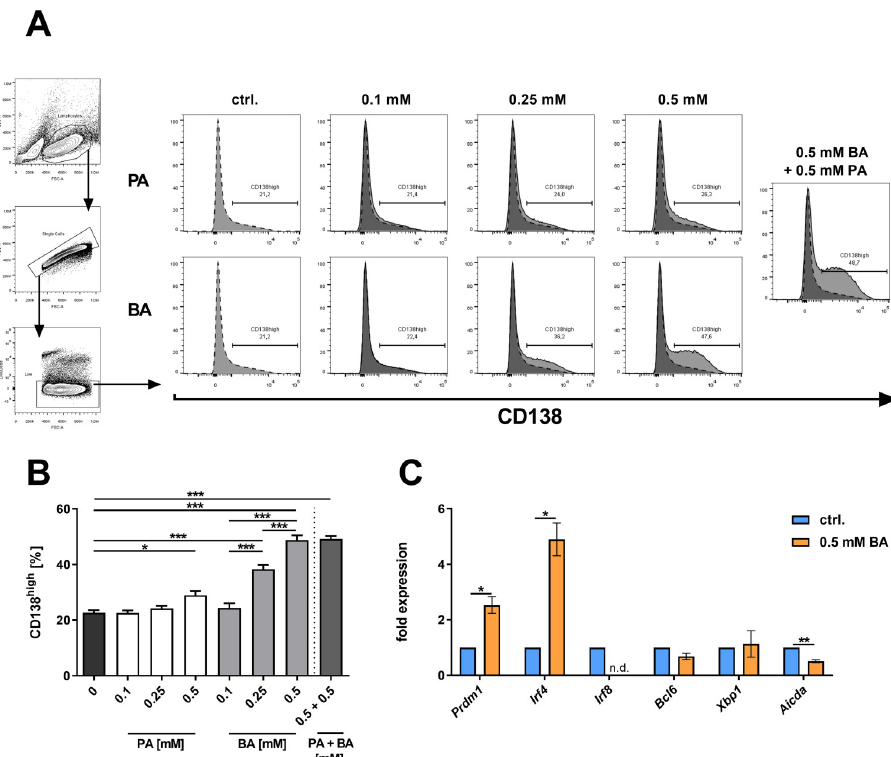
Fig 1. Butyrate promotes the differentiation of CD138 high PCs in isolated murine B cells. (A) Flow cytometric gating strategy and representative histogram plots of CD138 expression after treatment of isolated murine splenic B cells with increasing concentrations of PA and/or BA after 4 days of cell culture. (B) Frequencies of CD138 high PCs after treatment of isolated murine B cells with the indicated concentrations of PA and/or BA after 4 days of cell culture (n = 5 per group). (C) Gene expression analysis of PC transcription factors in isolated murine splenic B cells after one day of cell culture in the presence of 0.5 mM BA (n = 3). � p < 0.050, �� p < 0.010, ��� p <